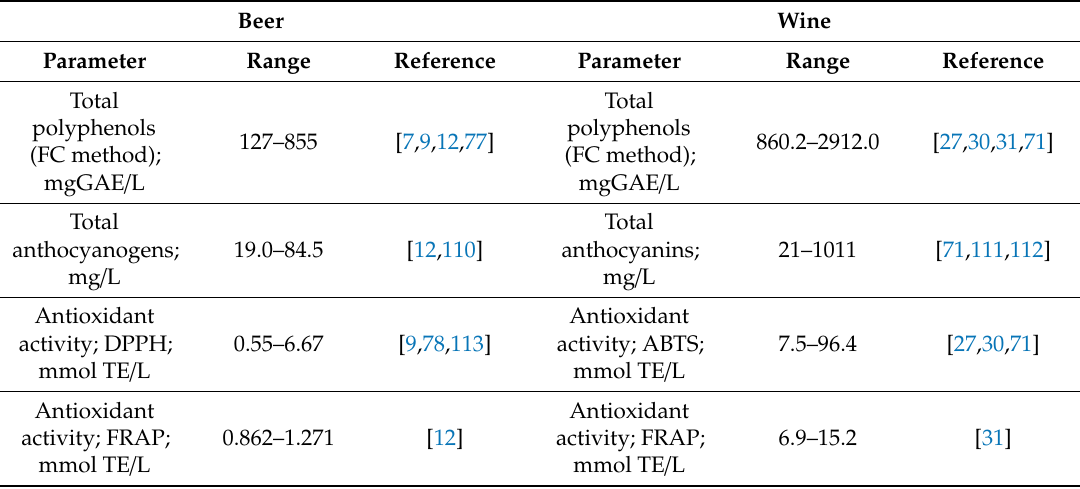
Table 2. Ranges of total content of polyphenolic compounds and some phenolic classes, as well as antioxidant activity measured with di ff erent analytical tools.